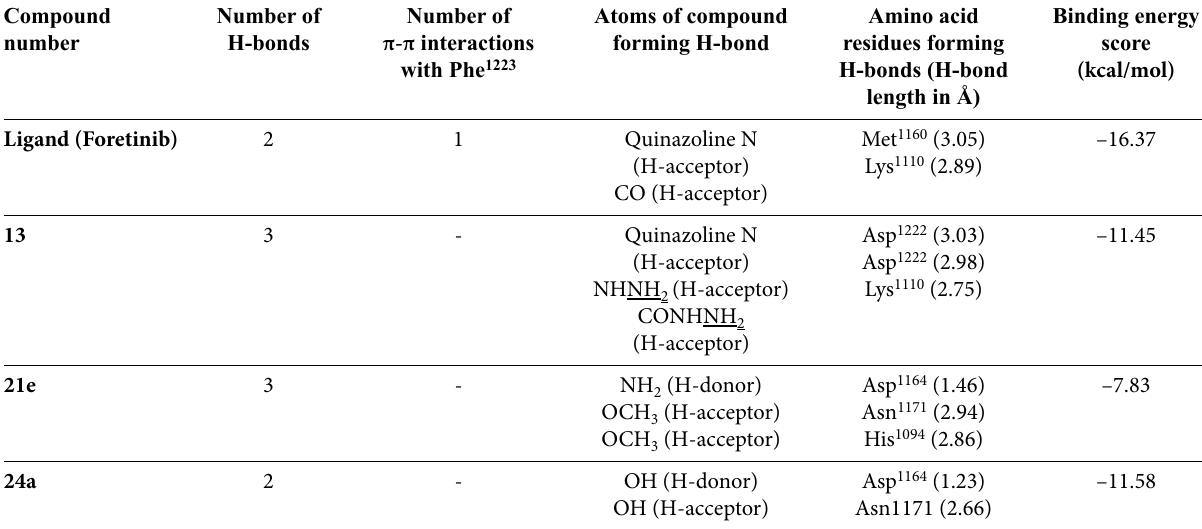
Table 6. Docking study data showing amino acid interactions and the hydrogen bond lengths of target compounds and foretinib on c-Met kinase enzyme. Compound Number of Number of Atoms of